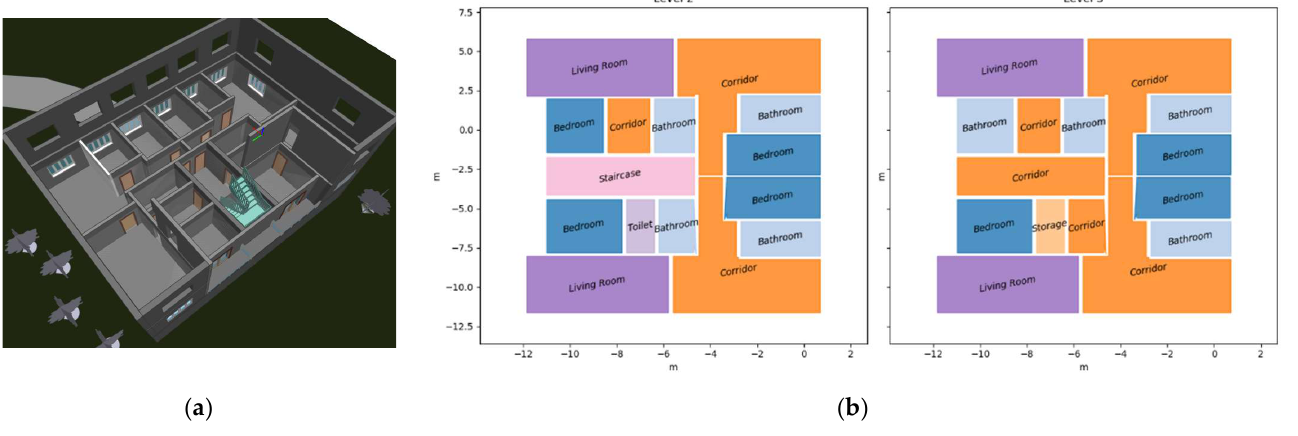
Figure 3. Confusion matrix for classification ( a ) of all the training and validation data, for which we obtained an accuracy of 72%. ( b ) For the validation nodes alone (which were 20% of the total nodes),we obtained an accuracy of 62%.